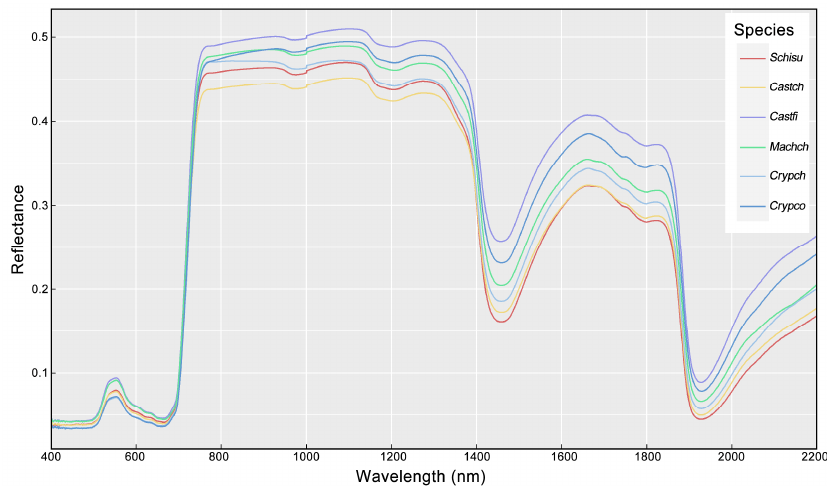
Figure 3. Interspecific variation in leaf hyperspectral reflectance.